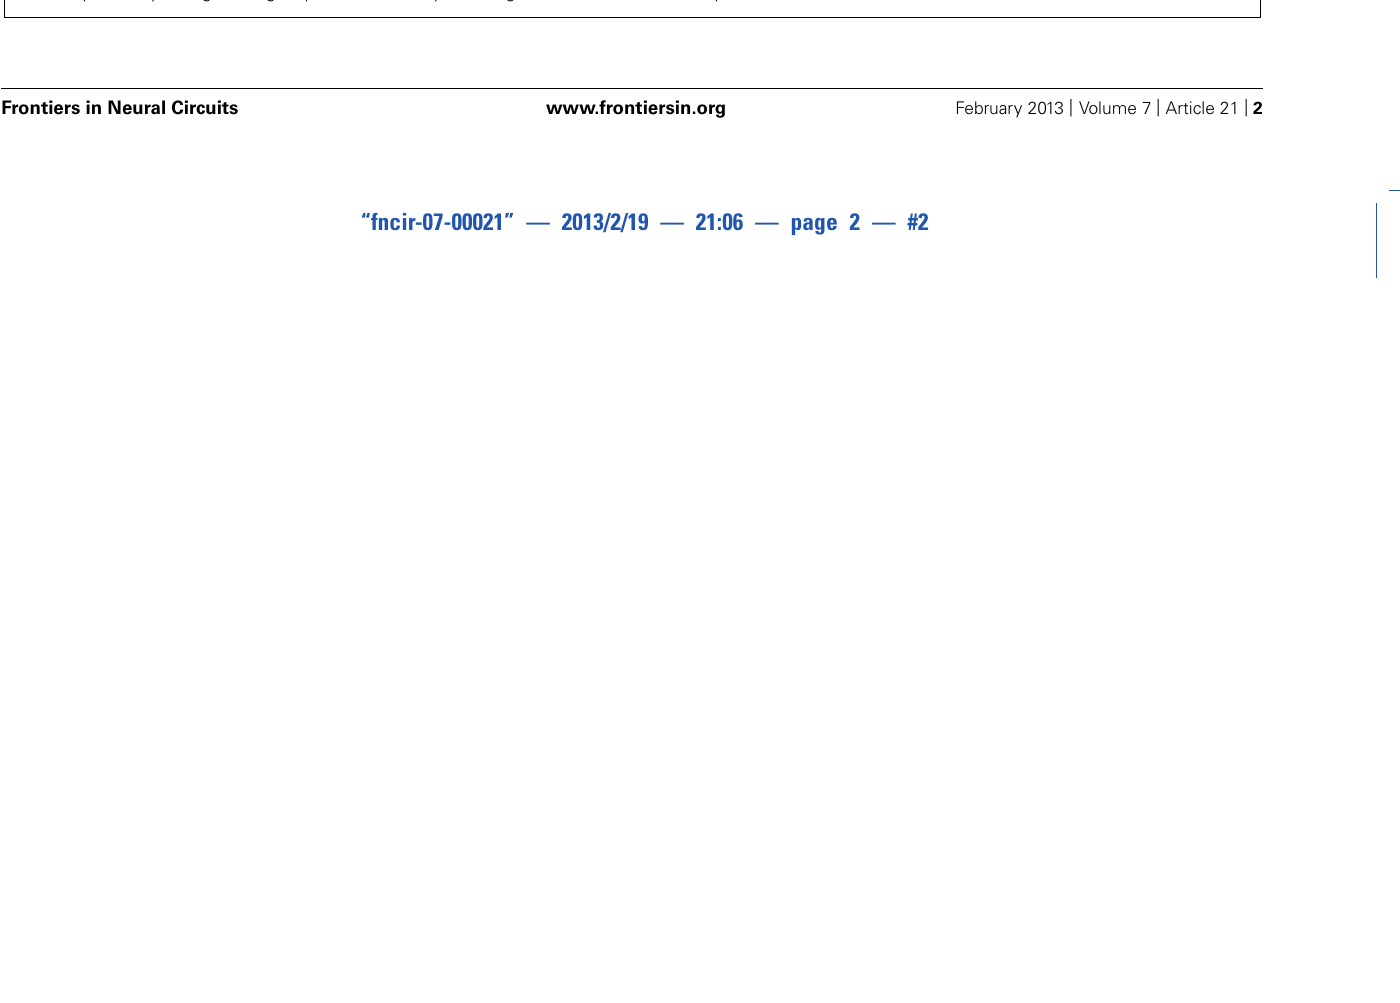
FIGURE 1 |Augmenting responses in motor cortex driven by ventrolateral (VL) thalamus activity at 7–14 Hz. (A) Intracellular (layerV) and field potential (FP) recordings showing an augmenting response evoked in motor cortex by electrical stimulation inVL at 10 Hz in a ketamine anesthetized rat (Castro-Alamancos and Connors, 1996b). (B) Behavioral state dependency of augmenting responses in a freely behaving rat